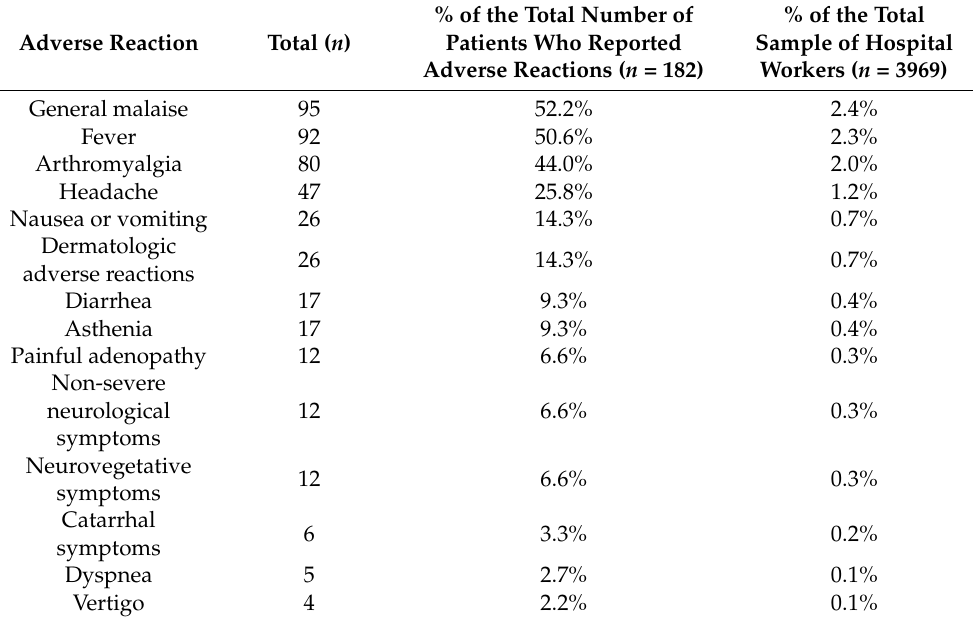
Table 2. Adverse reactions reported by hospital workers after BNT162b2